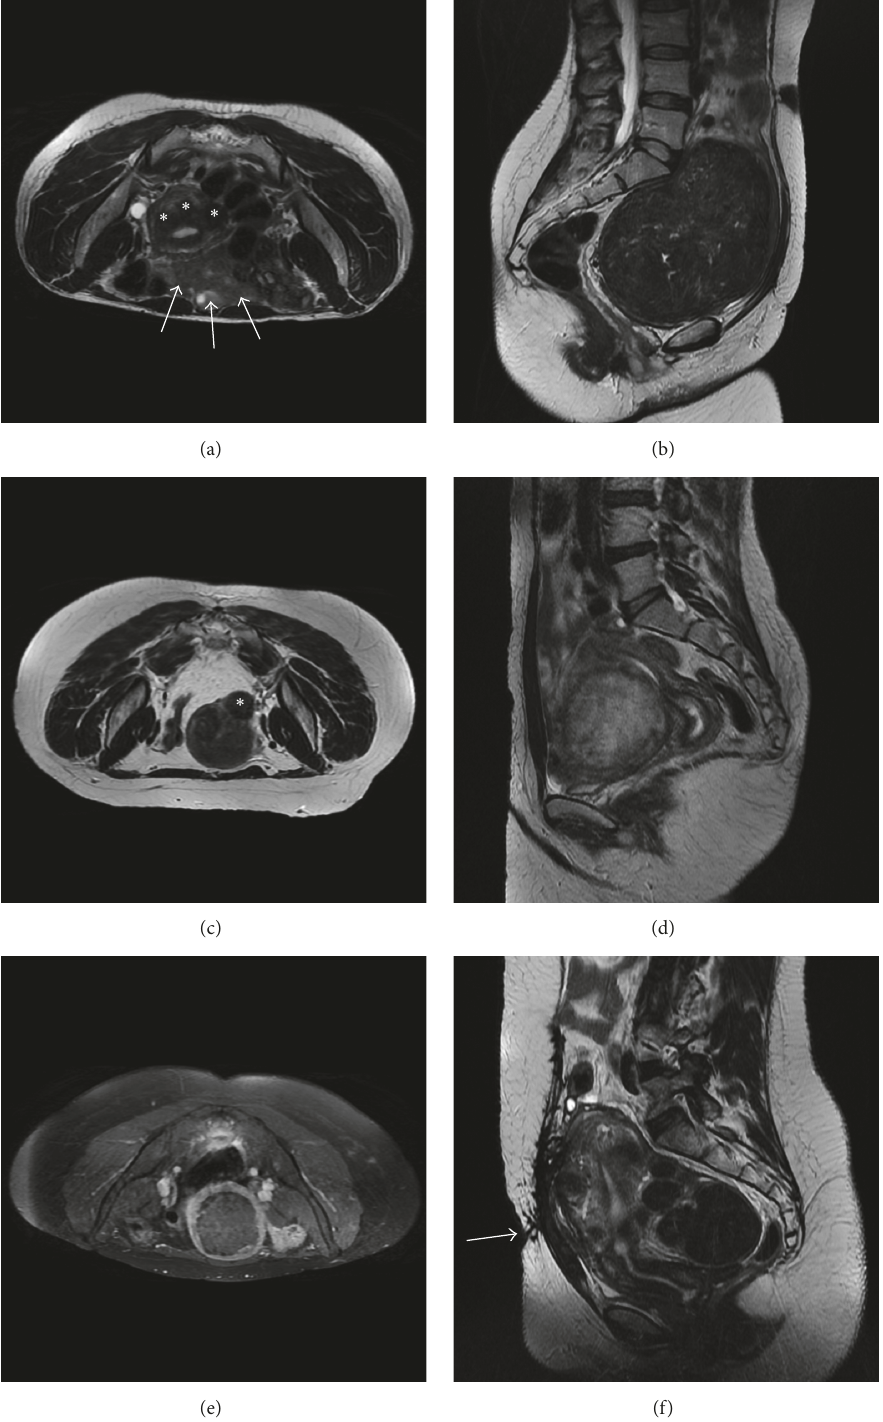
Figure 1: Illustrative pelvic MRI scans of excluded patients: (a) axial T2-w showing three small fibroids (asterisks) and many bowel loops (whitearrows)thatareinterposedbetweentheskinsurfaceandthehypothetictarget;(b)sagittalT2-wofalargefibroidwhichalmostoccupies the whole pelvis and is dangerously close to sacrum bone and nerves (this patient performed the screening MRI in supine feet first position since she reported some discomfort in maintaining the prone position); (c) axial T2-w showing a small and pedunculated subserosal fibroid (asterisk); (d) sagittal T2-w of a “bright” untreatable cellular fibroid; (e) axial T1-w with fat saturation acquired after intravenous injection of paramagnetic contrast medium showing a nonenhancing fibroid; (f) sagittal T2-w of a patients with a bulky scar in abdominal skin (white